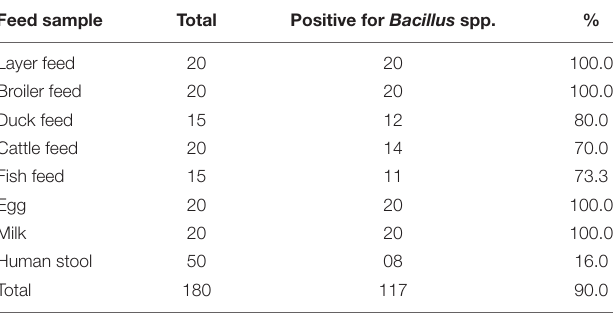
TABLE 2 | Positive Bacillus spp. in feed and other samples.